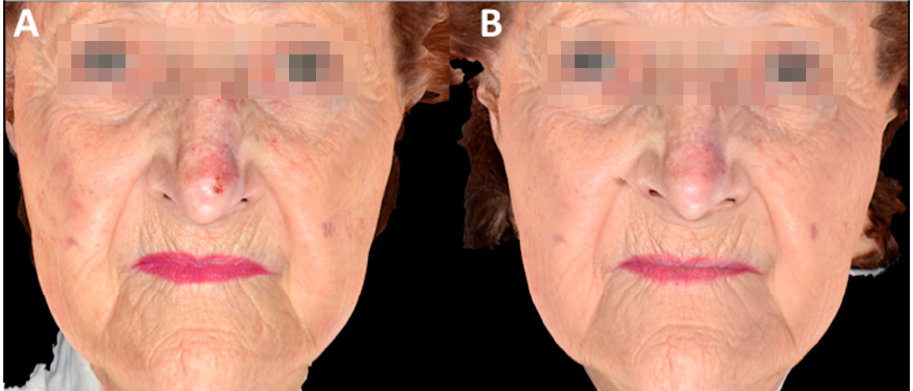
Figure 4. 3D images of complete clinical response of AK at the nose treated with MAL-PDT using IPL as light source: ( A ) before treatment and ( B ) at six months follow-up. Cosmetic outcome was rated as excellent.